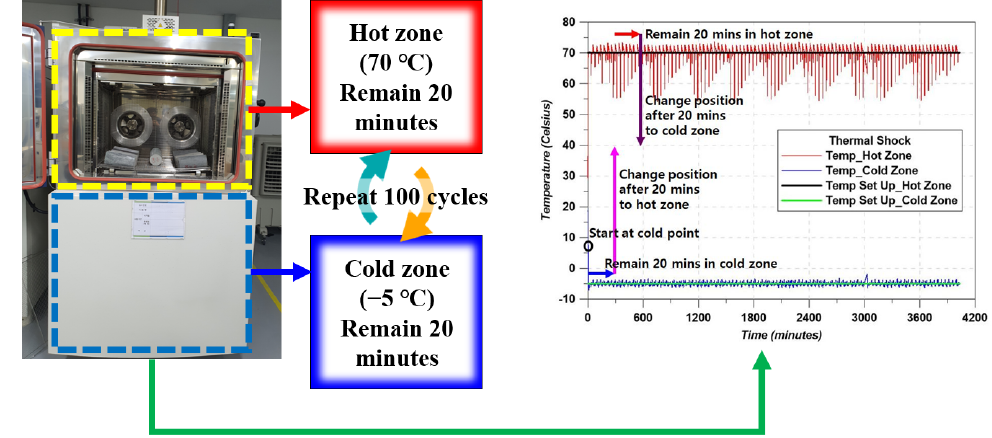
Figure 7. RCTA test concept.